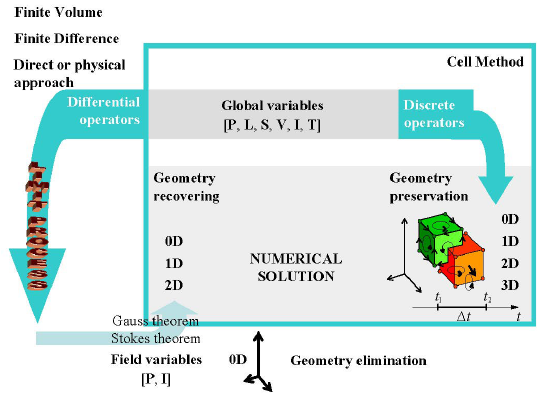
Figure 6: Building an algebraic formulation through the direct or physical approach, the finite volume method, the finite difference method, and the Cell